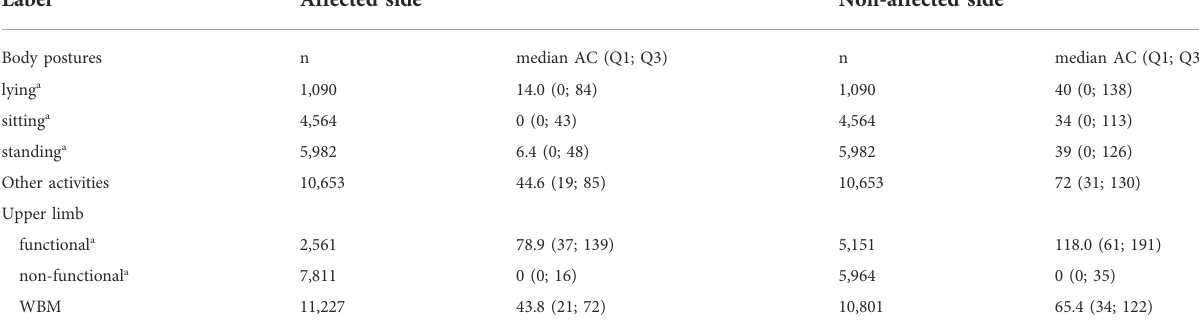
TABLE 2 Descriptives of activity counts across labels.